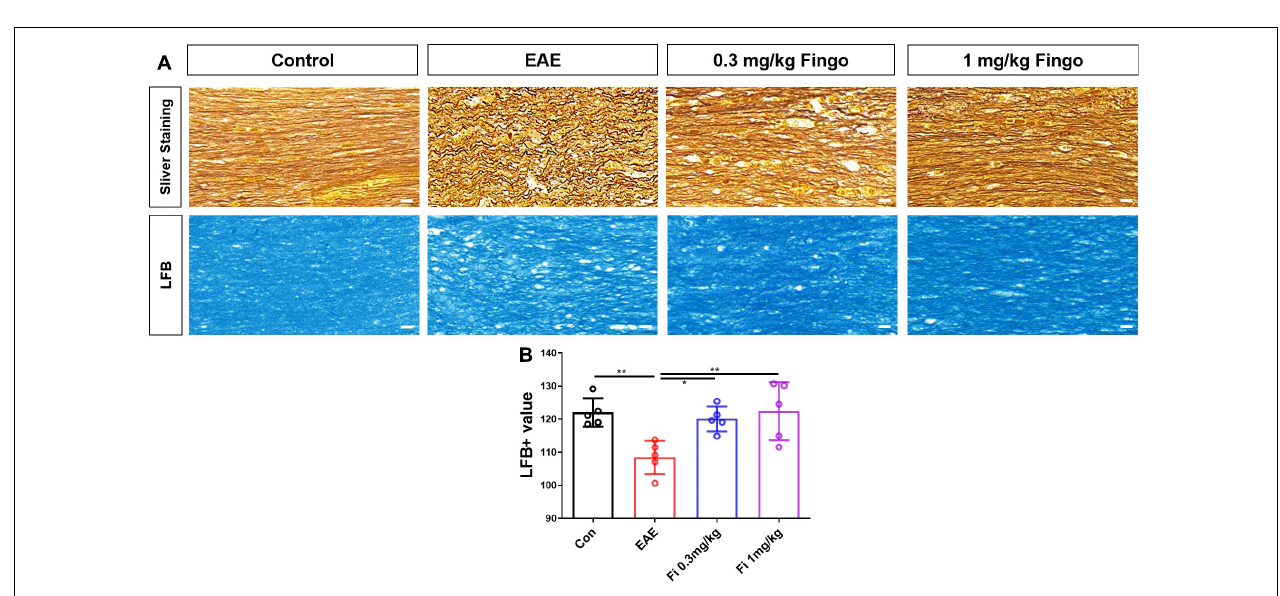
FIGURE 2 | Inflammatory cell infiltration in the optic nerve with fingolimod treatment. (A) Retina and optic nerve were stained with H&E. The degeneration of the retina and optic nerve was indicated by arrows. (B) Cellular infiltration was measured by H&E scores in the retina. (C) The cellular infiltration was measured by H&E scores in the optic nerve. Values represented as mean ± SD. One-way ANOVA plus Tukey’s multiple comparisons. * P < 0.05, ** P < 0.01, *** P < 0.001. Scale bar = 5 µ m.